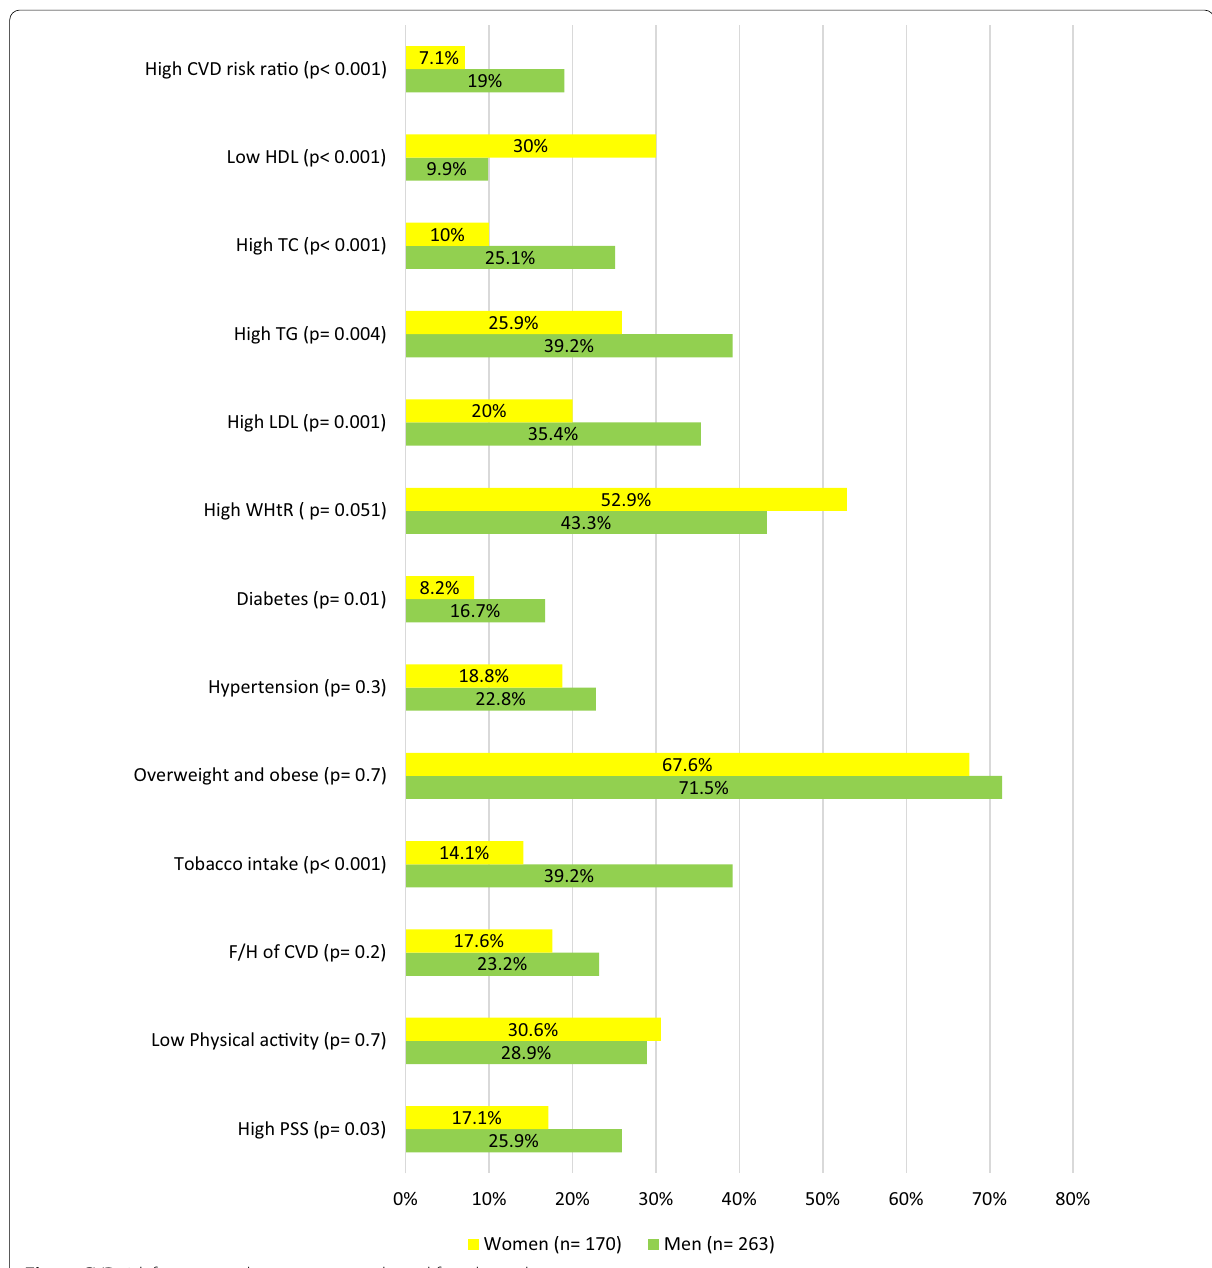
Fig. 1 CVD risk factor prevalence among male and female